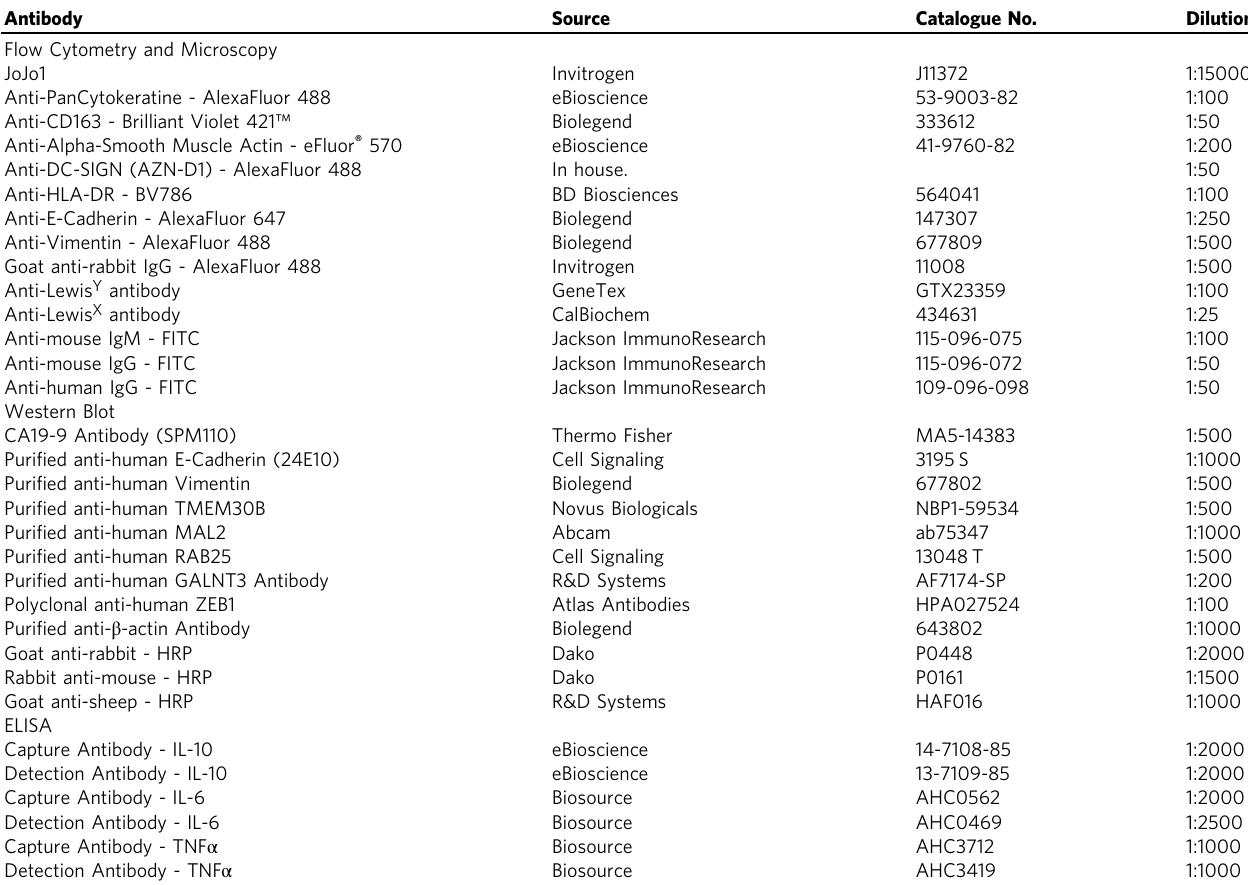
Table 1 List of Antibodies used in this paper.